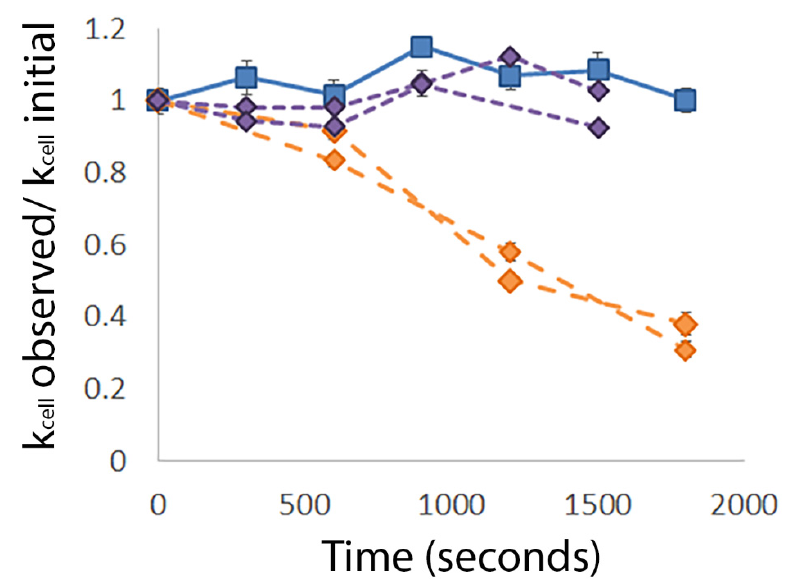
Figure 2. Treatment with MAG2 causes a decrease in stiffness in some biofilm cells but not in others. FD measurements were taken on cells from untreated (blue squares) and treated (purple and orange diamonds) biofilms over a 30 min time period and the k cell was calculated as described in Equation (1). Each line represents a single cell and each point represents the average k cell calculated from 5 FD measurements. Error bars represent the standard deviation, though the value is sometimes too small to see. To account for the heterogeneity of cell stiffness within the population, each average was normalized to the k cell at time 0. These data are representative of the cells observed (untreated n = 14, treated n = 36).